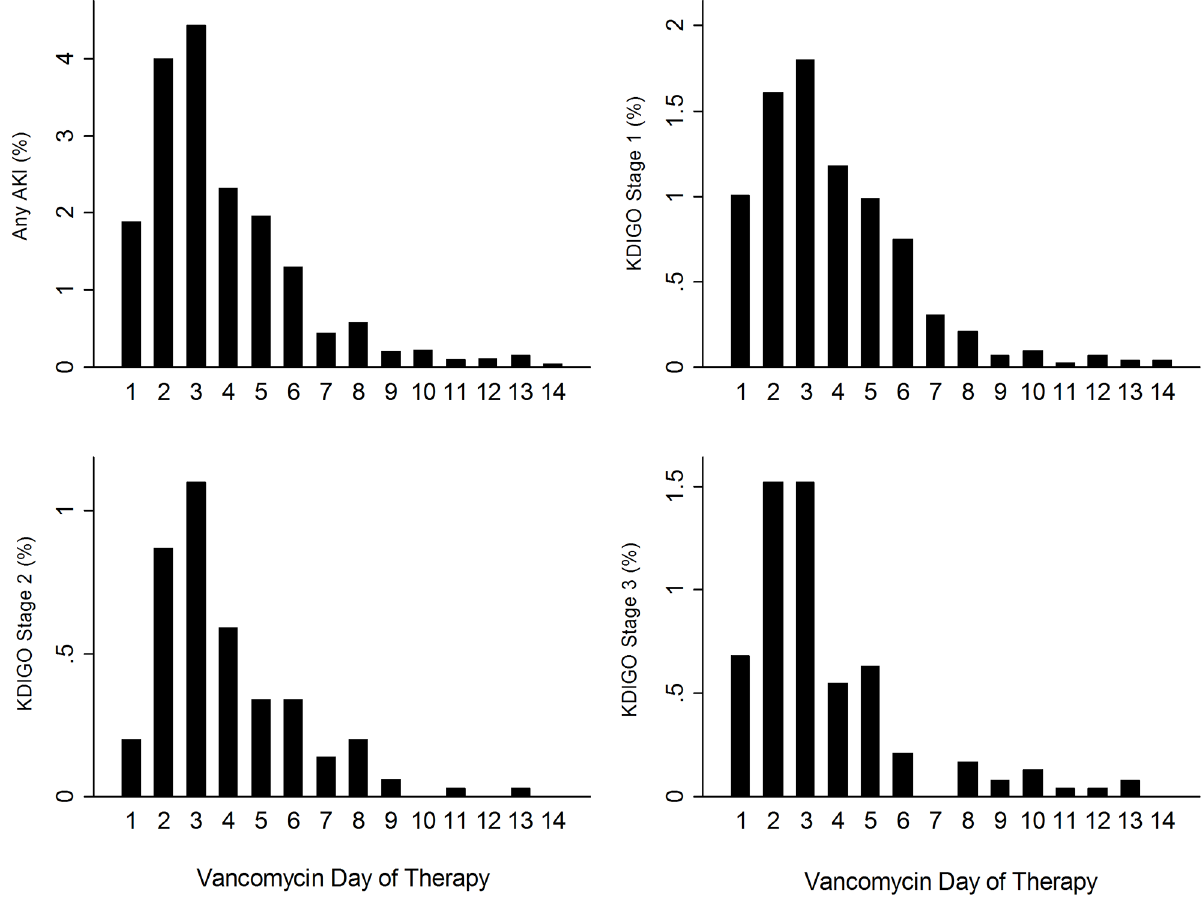
Fig 1. Percent of patients achieving maximum KDIGO status by vancomycin day of therapy. The incidence of AKI occurs primarily around day 3 of vancomycin therapy.